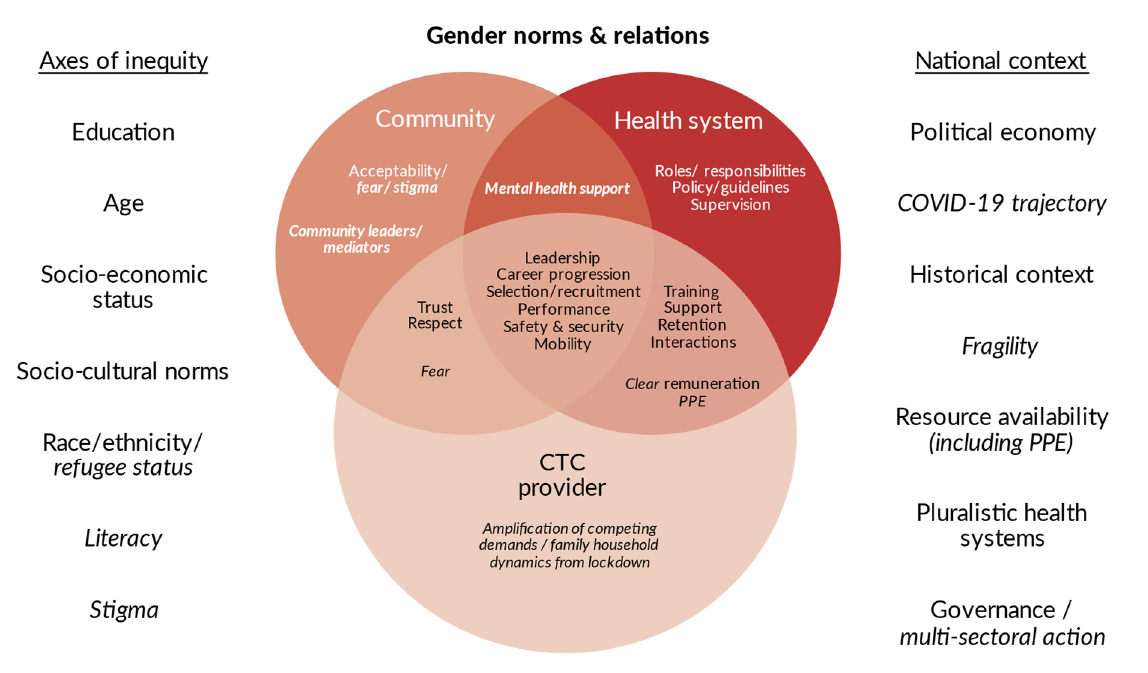
Figure 3. Gendered experiences of CTC providers in fragile settings during COVID‑19 (adapted from Steege et al. 2018). Key: italics—additions from this study.